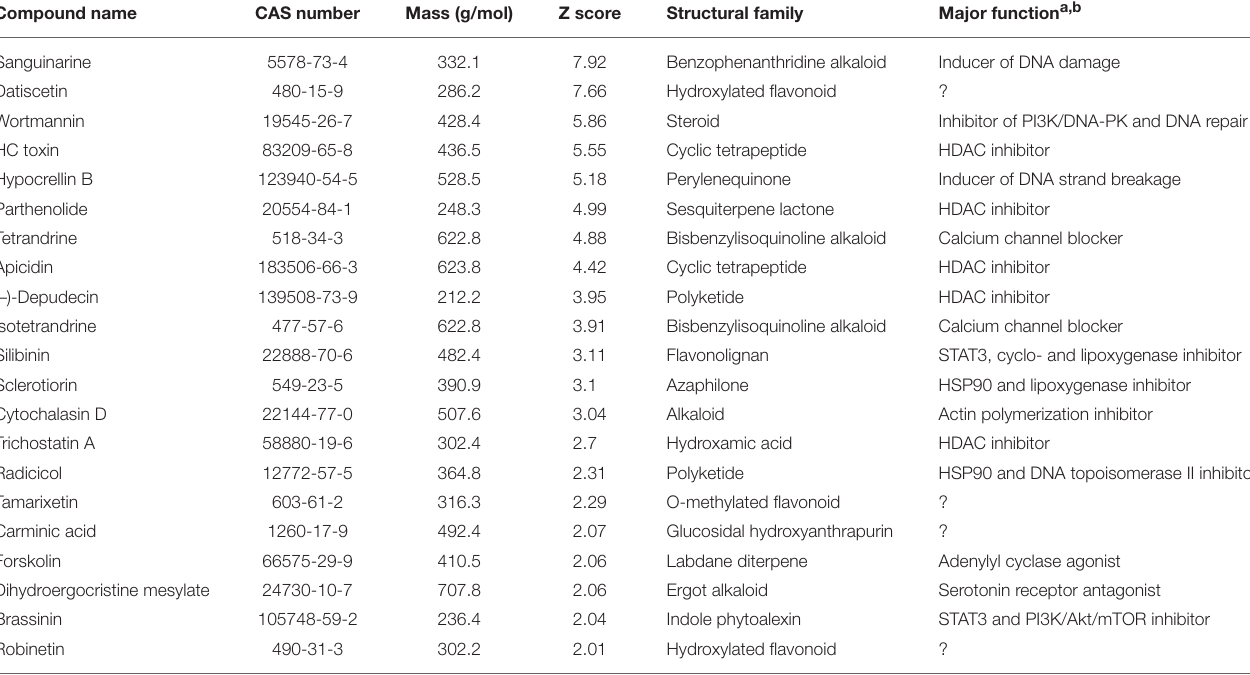
TABLE 2 | The Z-scores and major functions of 21 hits at 20 µ g/ml from primary screening of the Natural Products